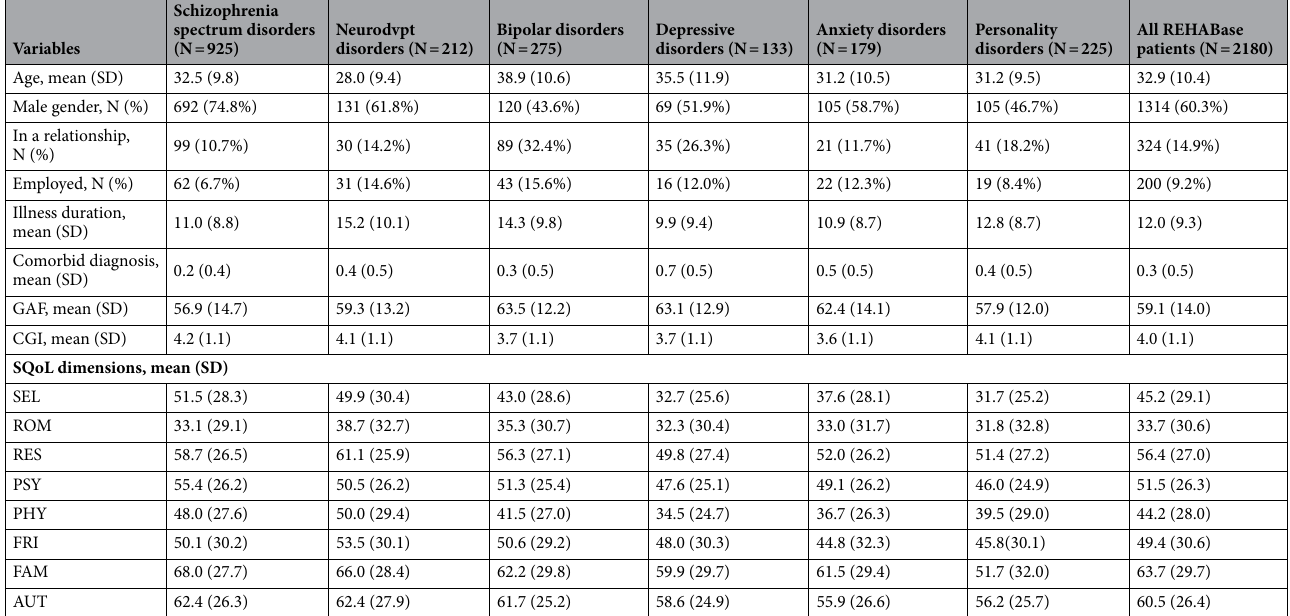
Table 1. Clinical and socio-demographic characteristics of participants. QoL Quality of life dimensions: SEL self-esteem, ROM romantic life, RES resilience, PSY psychological well-being, PHY physical well-being,